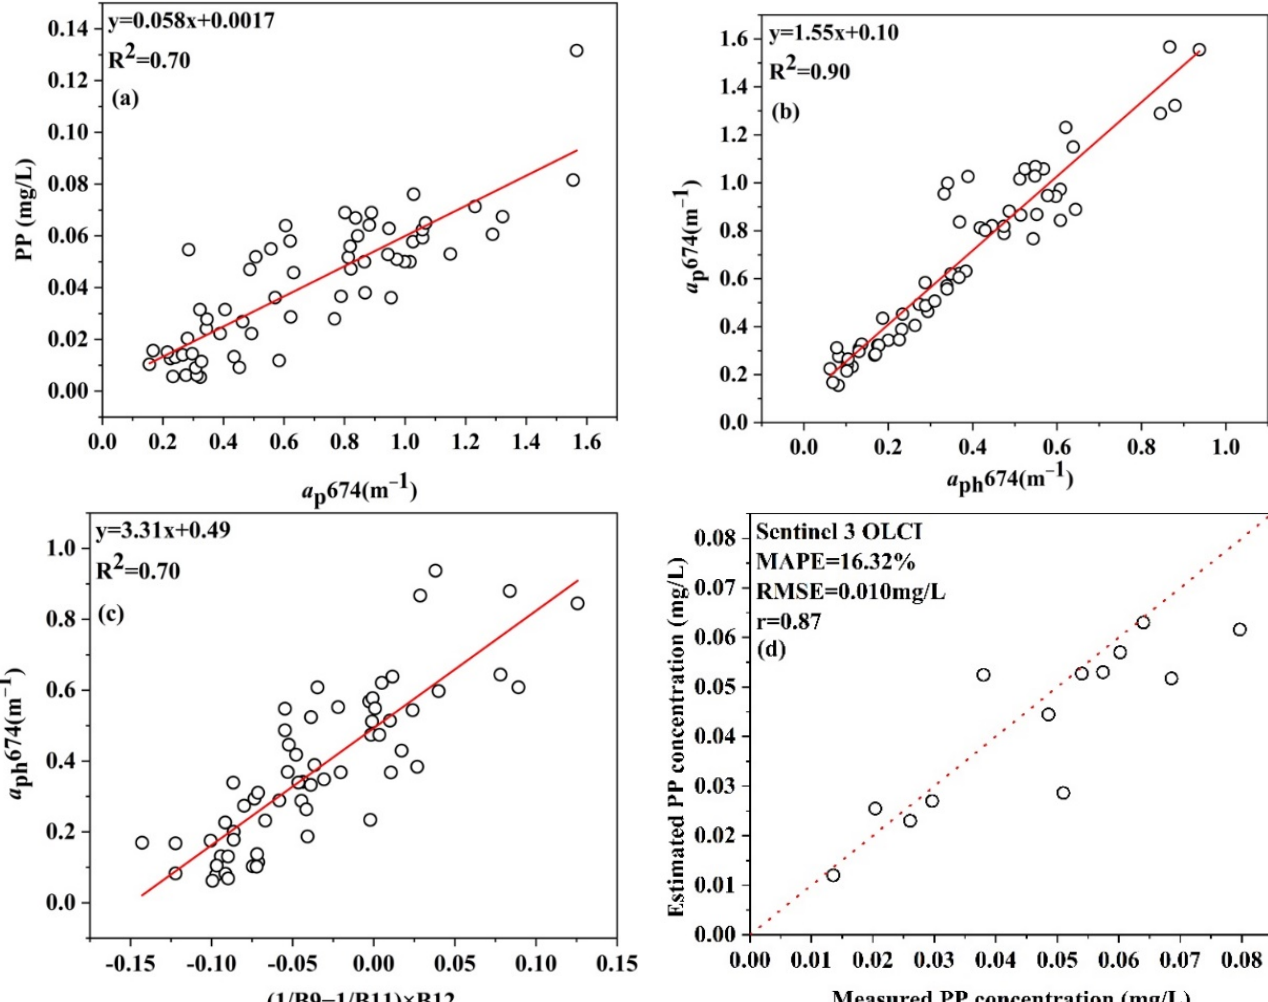
Figure 5. Panels ( a – d ) provide comparisons of the measured PP values and those estimated based on Sentinel 3 OLCI